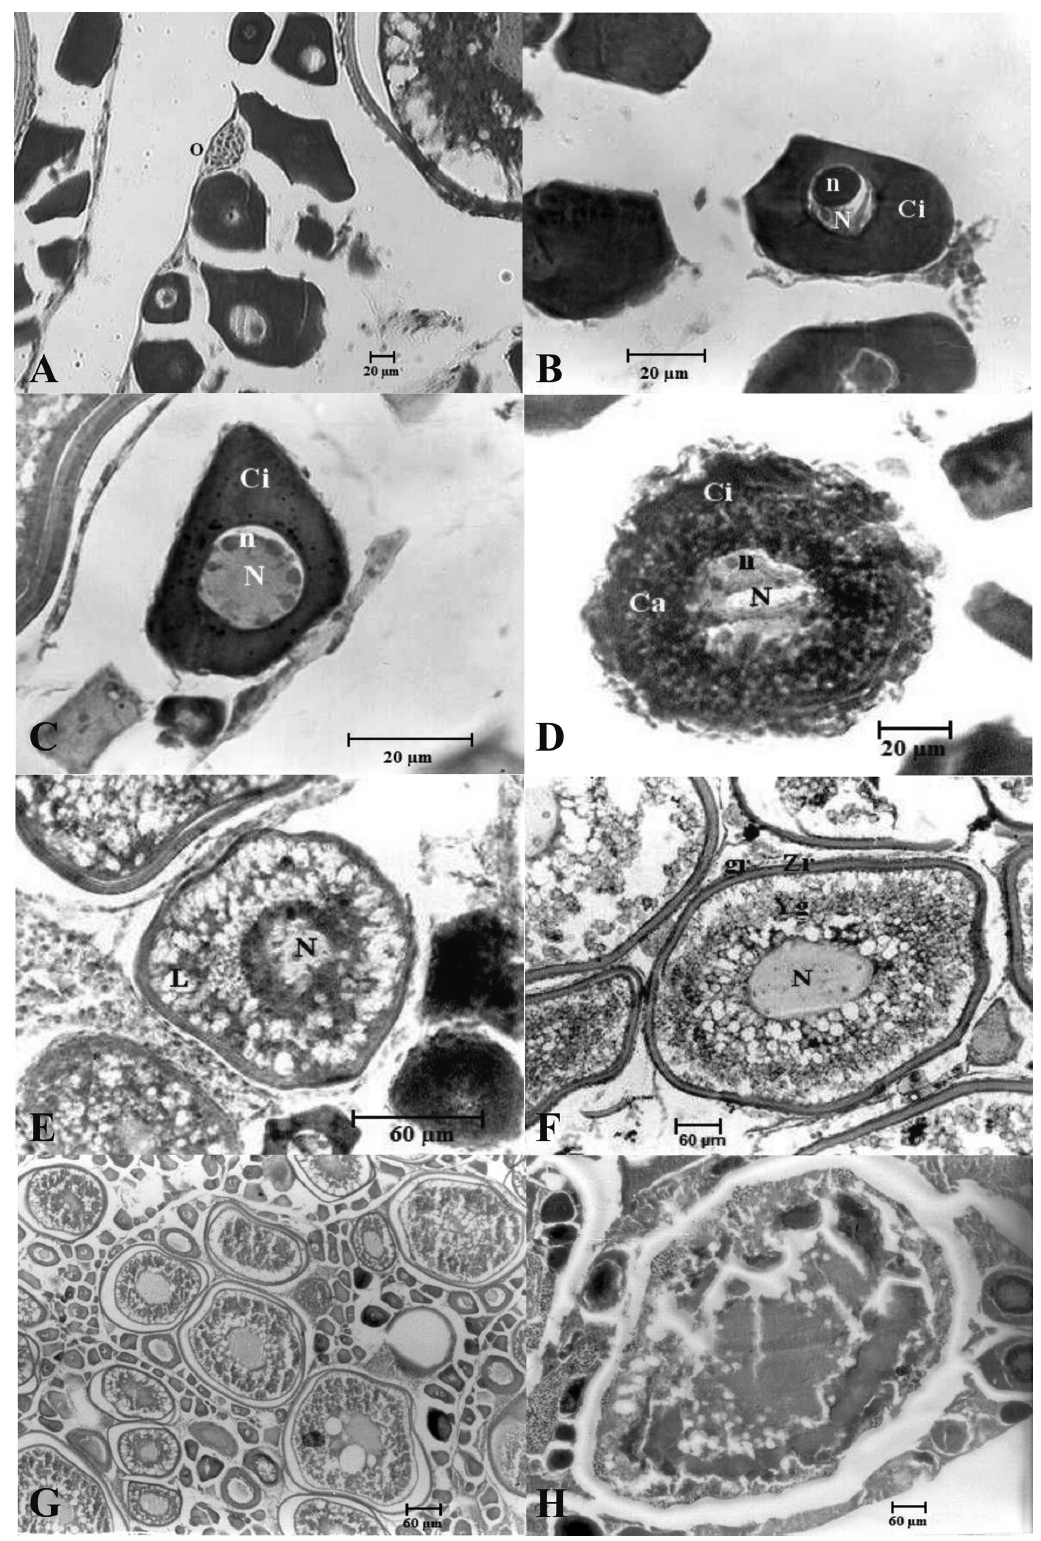
F IG . 1. – Photomicrographs of oocytes at different developmental stages in the white grunt, H. plumieri . A) Oogonia, B) Chromatin nucleo- lus stage, C) perinucleolus stage, D) cortical alveoli stage, E) Lipid vesicle stage, F) Yolk granules stage, G) transverse section through a ripe ovary showing oocytes at different maturity stages, H) Atretic oocyte. Ca: Cortical alveoli., Ci: cytoplasm, gr: granulose, L: lipid droplets, N: nucleus, n: nucleolus, O: oogonia, Yg: yolk granules, Zr: zona